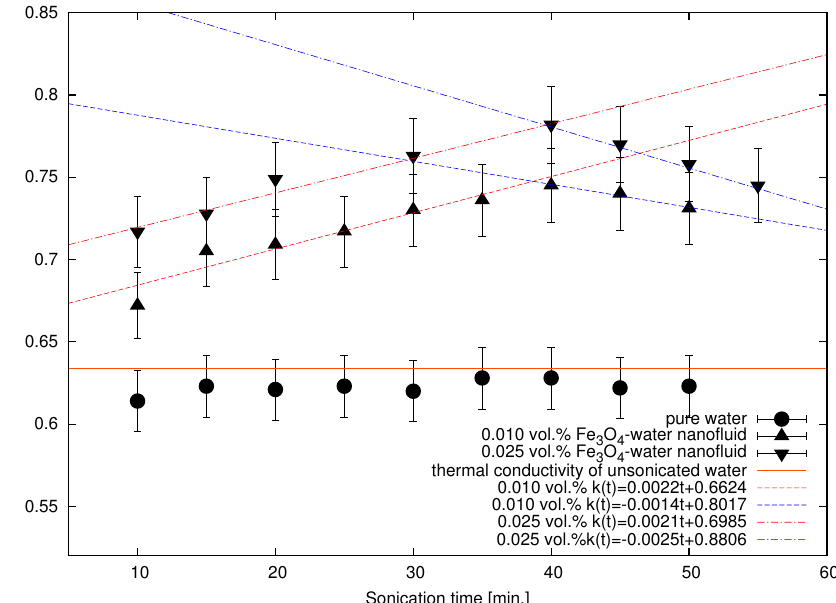
Figure 6. Thermal conductivity of pure water and Fe 3 O 4 nanofluid at different concentrations as a function of ultrasonication time. Symbols present experimental data; solid line shows the value of thermal conductivity of unsonicated water; dotted lines present linear increase and decrease in thermal conductivity during